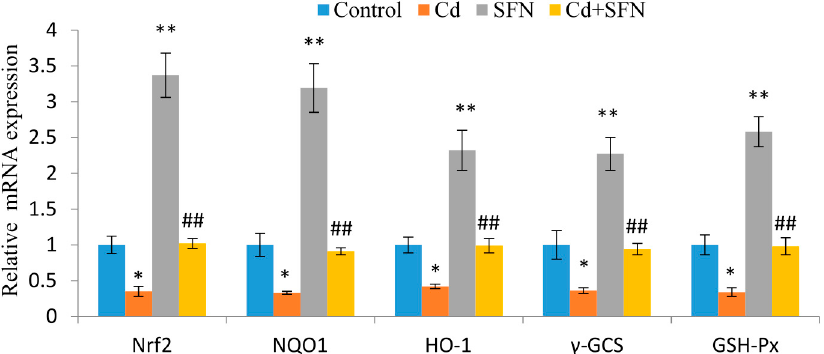
Figure 4. Effects of sulforaphane (SFN) treatment on CdCl 2 -induced transcription of nuclear factor- erythroid 2-related factor 2 ( Nrf2 ), glutathione peroxidase ( GSH-Px ), and γ -glutamyl cysteine synthetase ( γ -GCS ) in mouse testis. Values represent mean ± SEM of 10 mice in each group; * p < 0.05, ** p < 0.01 vs. control group; ## p < 0.01 vs. cadmium group.